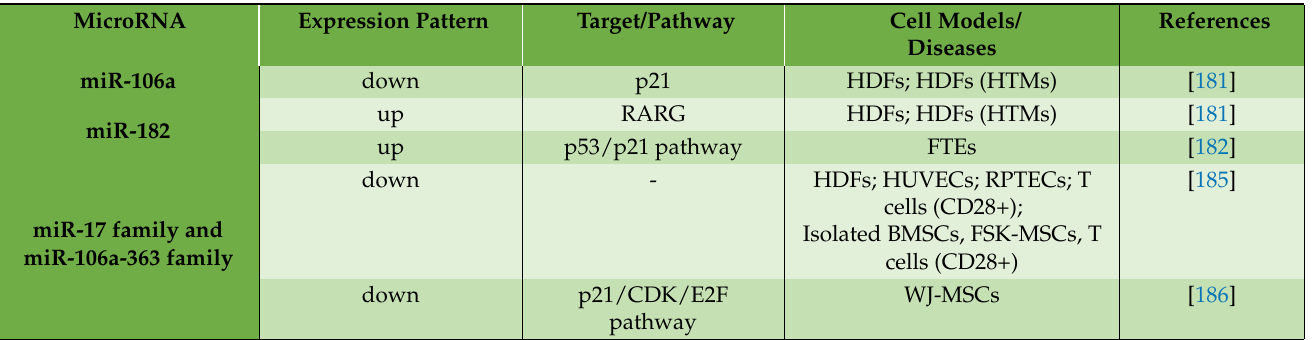
Table 1. List of microRNAs whose expression and targets/pathways are implicated in oxidative stress-induced senescence. Luciferase assay not